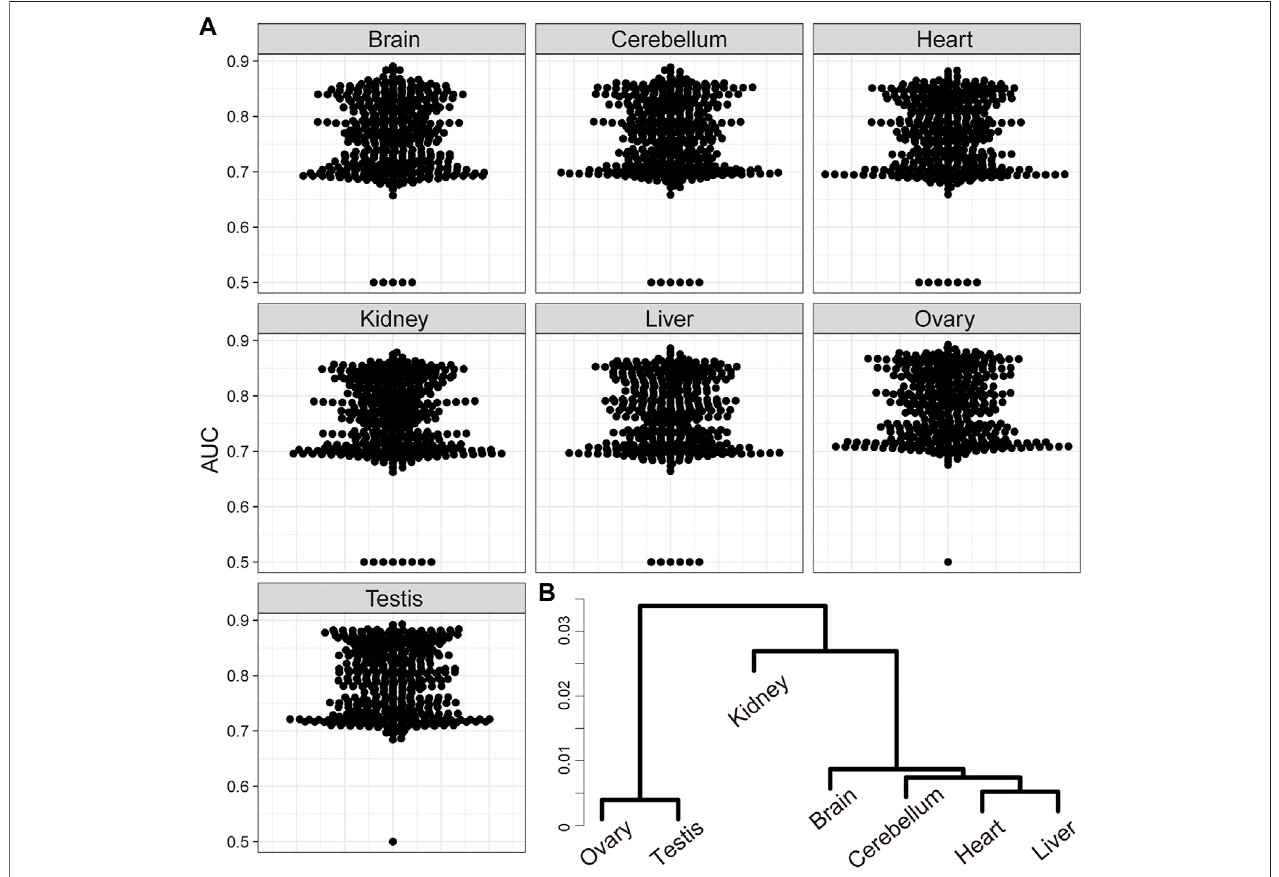
FIGURE 5 | Validation of time-course individual RNA-Seq-based GRN inference with a public organ-level RNA-Seq data. (A) Scatter plots of area under the curve (AUC) target selection for each transcription factor (TF) based on the absolute values of A inferred from public time-course organ-level RNA-Seq data using SCODE. (B) Hierarchical clustering of the inferred GRNs from each organ-level RNA-Seq